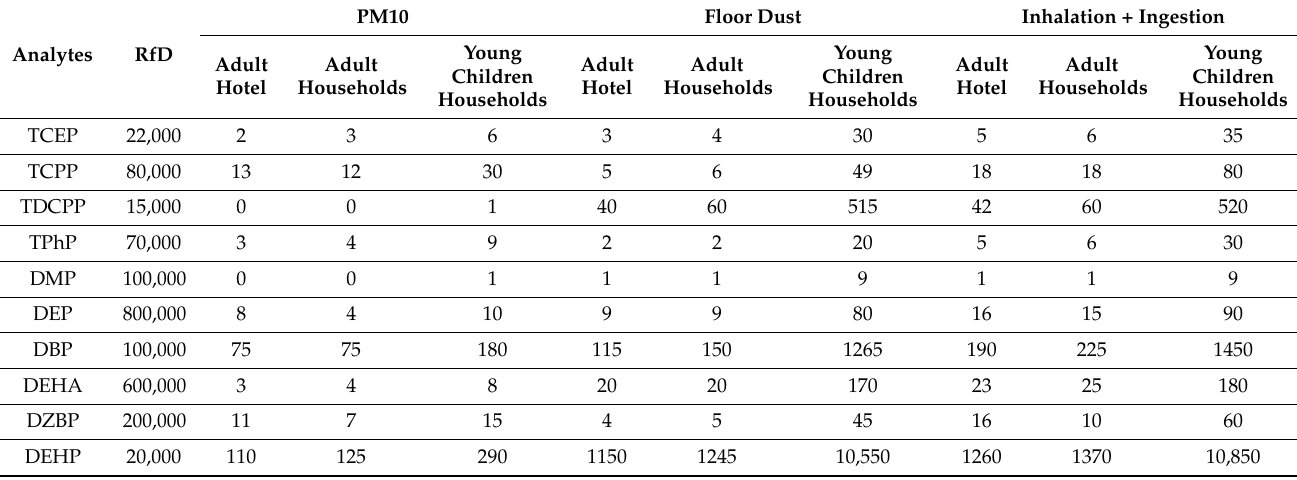
Table 4. Estimated daily exposure (ng kg − 1 bw d − 1 ) to OPEs and phthalates via dust ingestion and PM10 inhalation for Saudi young children and adults from their